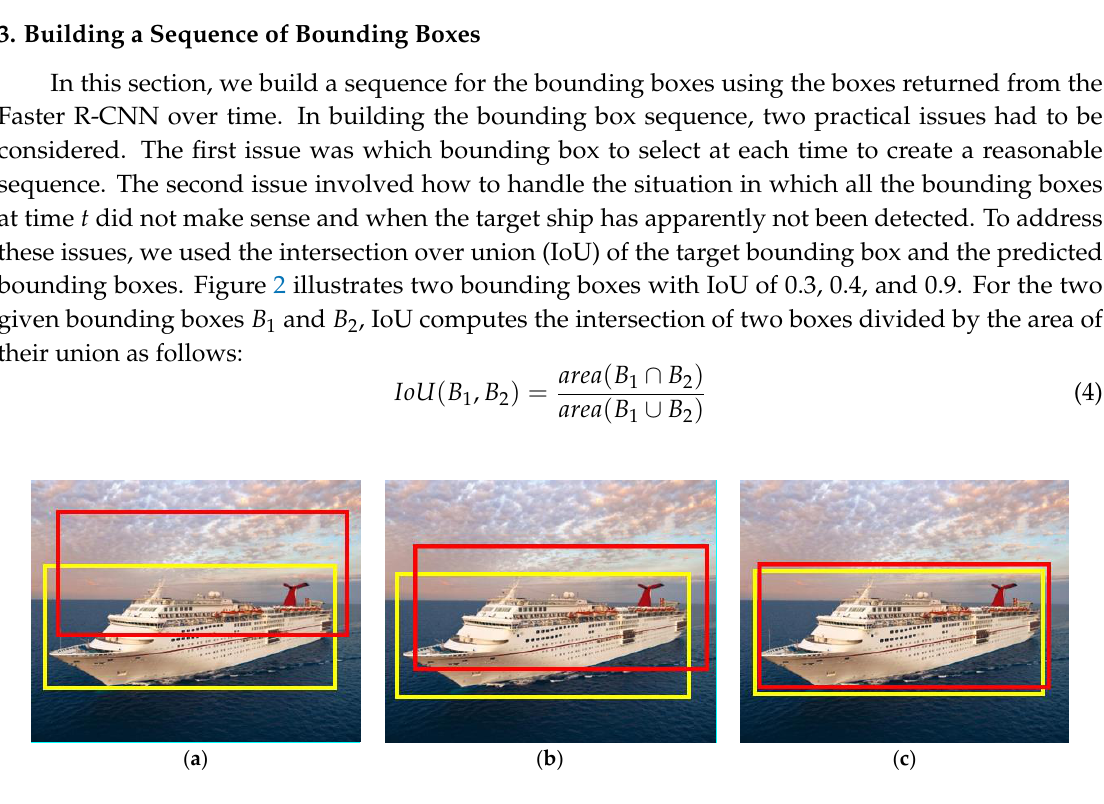
Figure 2. An illustration of two bounding boxes with an Intersection over Union (IoU) of ( a ) 0.3, ( b ) 0.5, and ( c ) 0.9.